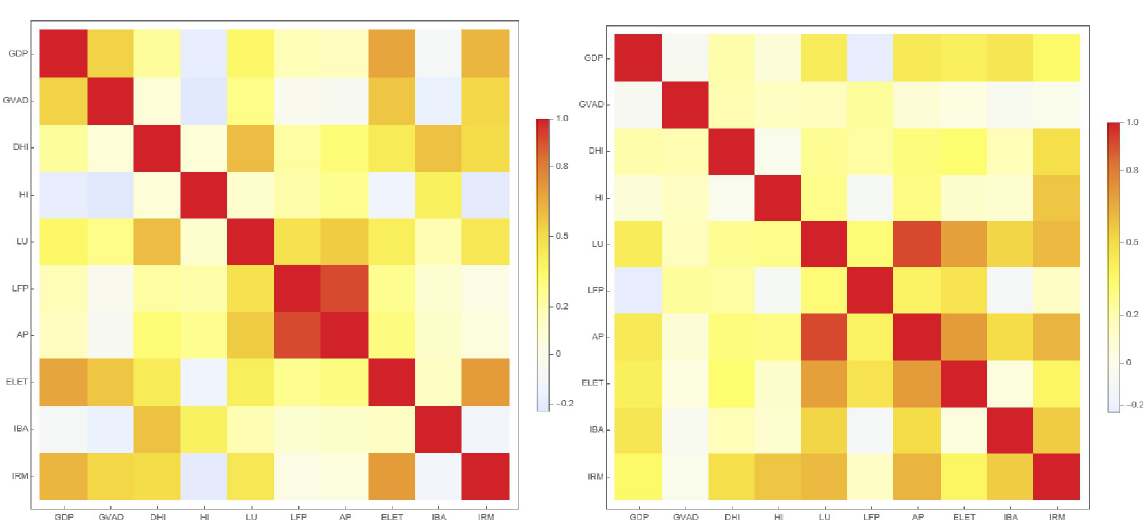
Fig 1. The Kendall correlation coefficient for Central and Eastern Europe regions (left hand side) and Western Europe regions (right hand side).